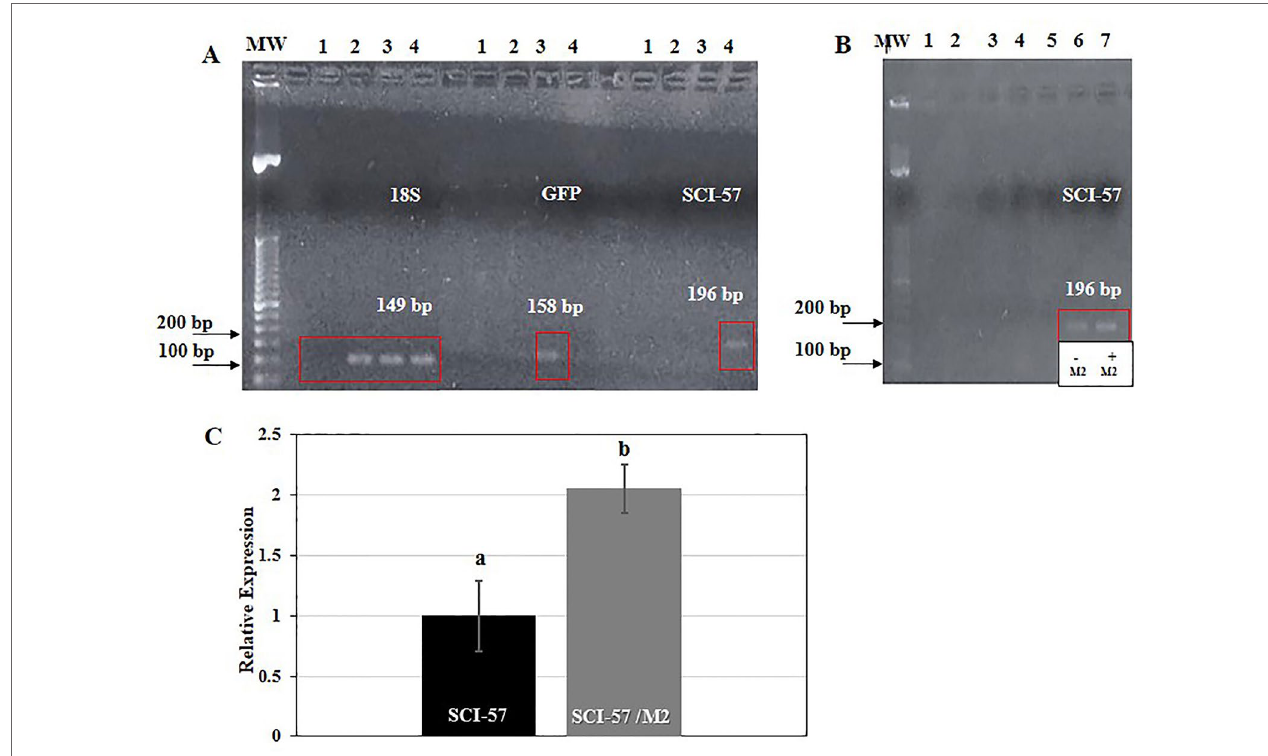
FIgUrE 3 | (A) RT-PCR analysis of 18S, GFP and SCI-57 gene expression. Reactions were performed in the same conditions for all lanes, with specific primer pairs: 18S (149 bp), GFP (158 bp) and SCI-57 (196 bp). Mw: Molecular weight marker; lane 1: No template controls (NTCs); lane 2: No-agroinfiltrated N.b; lane 3: Plants agroinfiltrated with GFP; lane 4: Plants agroinfiltrated with SCI-57. The red square indicates the location of the amplification products. (B) RT-PCR analysis of SCI-57 gene expression with and without M2 co-expression. Reactions were performed in the same conditions for all lanes, with specific primer pairs: SCI-57 (196 bp). Mw, Molecular weight marker; lane 3, NTCs; lane 4, No-agroinfiltrated N.b; lane 5, Plants agroinfiltrated with GFP; lane 6, Plants agroinfiltrated with SCI-57; lane 7, Plants agroinfiltrated with SCI-57 co-expressing M2. The red square indicates the location of the amplification products. (C) Analysis of the relative expression of SCI-57 with and without the M2 co-expression by qRT-PCR. Relative expression was evaluated employing the RT-PCR primers ( Supplementary Table S1 ). Expression was normalized against 18S rRNA gene expression. Results are presented as the mean ± S.D. of three independent experiments in triplicate. Lowercase letters indicate significant differences according to the Mann-Whitney U test (p ≤